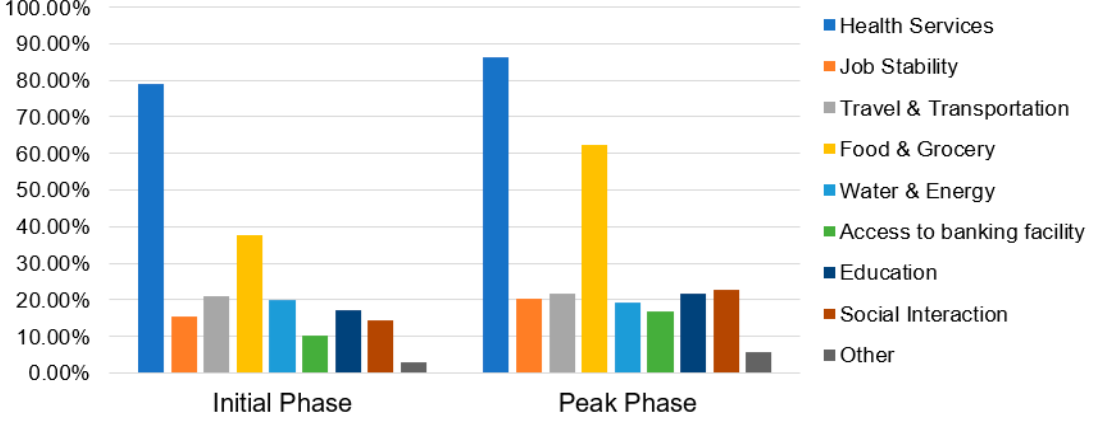
Figure 6. Immediate concerns identified by the survey respondents during COVID-19 lockdown.